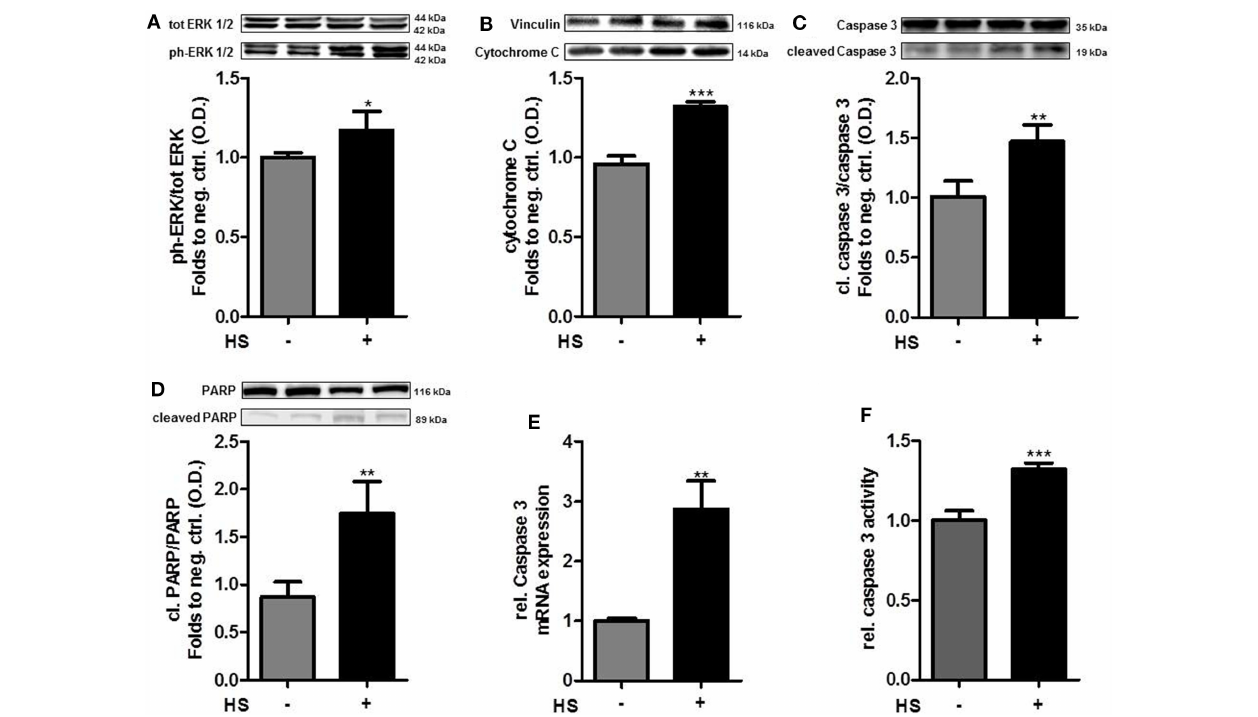
FIGURE 2 | Heparan sulfate induces a pro-apoptotic pathway. HL-1 cells exposed to 10 μ g/ml HS for 16h showed a significant increase in protein expression of (A) phospho-ERK 1/2, (B) cytochrome C, (C) cleaved PARP, and (D) cleaved caspase 3, compared to unstimulated cells. Protein expression was normalized to unstimulated cells. (E) Relative mRNA expressions of HL-1 cells exposed to HS were analyzed by quantitative real-time PCR, compared to unstimulated cells. Caspase 3 mRNA expression was normalized to reference gene S7 and unstimulated cells. (F) Relative caspase 3 activity of cardiomyocytes exposed to HS, compared to unstimulated cells. The data represent the mean (cid:6) SD of triplicate samples for three independent experiments. HS, heparan sulfate; PARP, poly-(ADP-ribose) polymerase; p-ERK, phospho-extracellular signal-regulated kinase; statistical significance was performed by using unpaired t -test. * p < 0.05; ** p < 0.01, and *** p < 0.001 vs. unstimulated